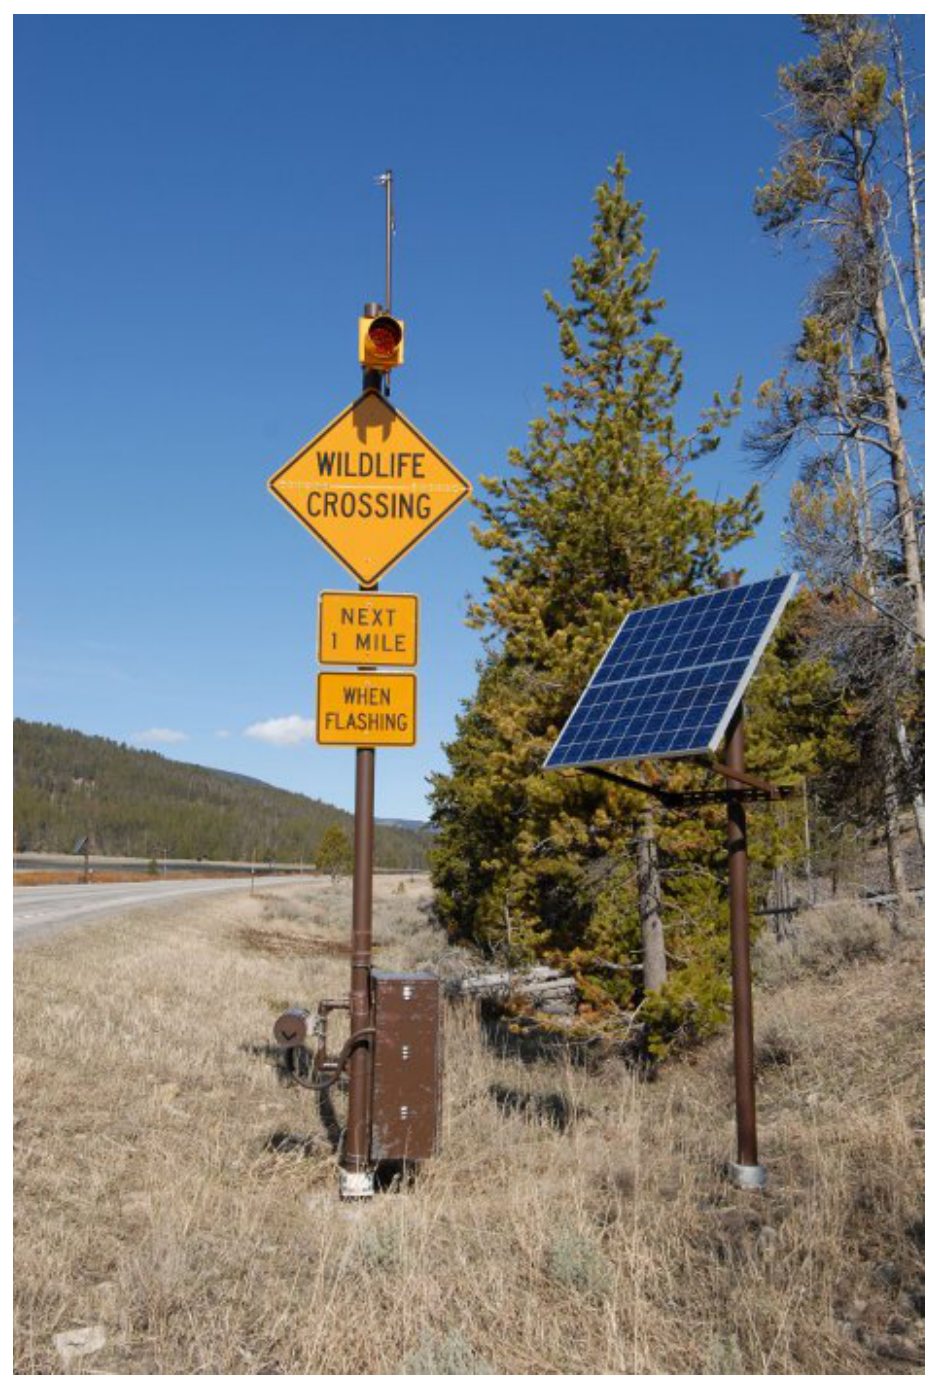
Fig. 5. Animal detection system along U.S. Highway 191 in Yellowstone National Park, Montana, USA (copyright: Marcel